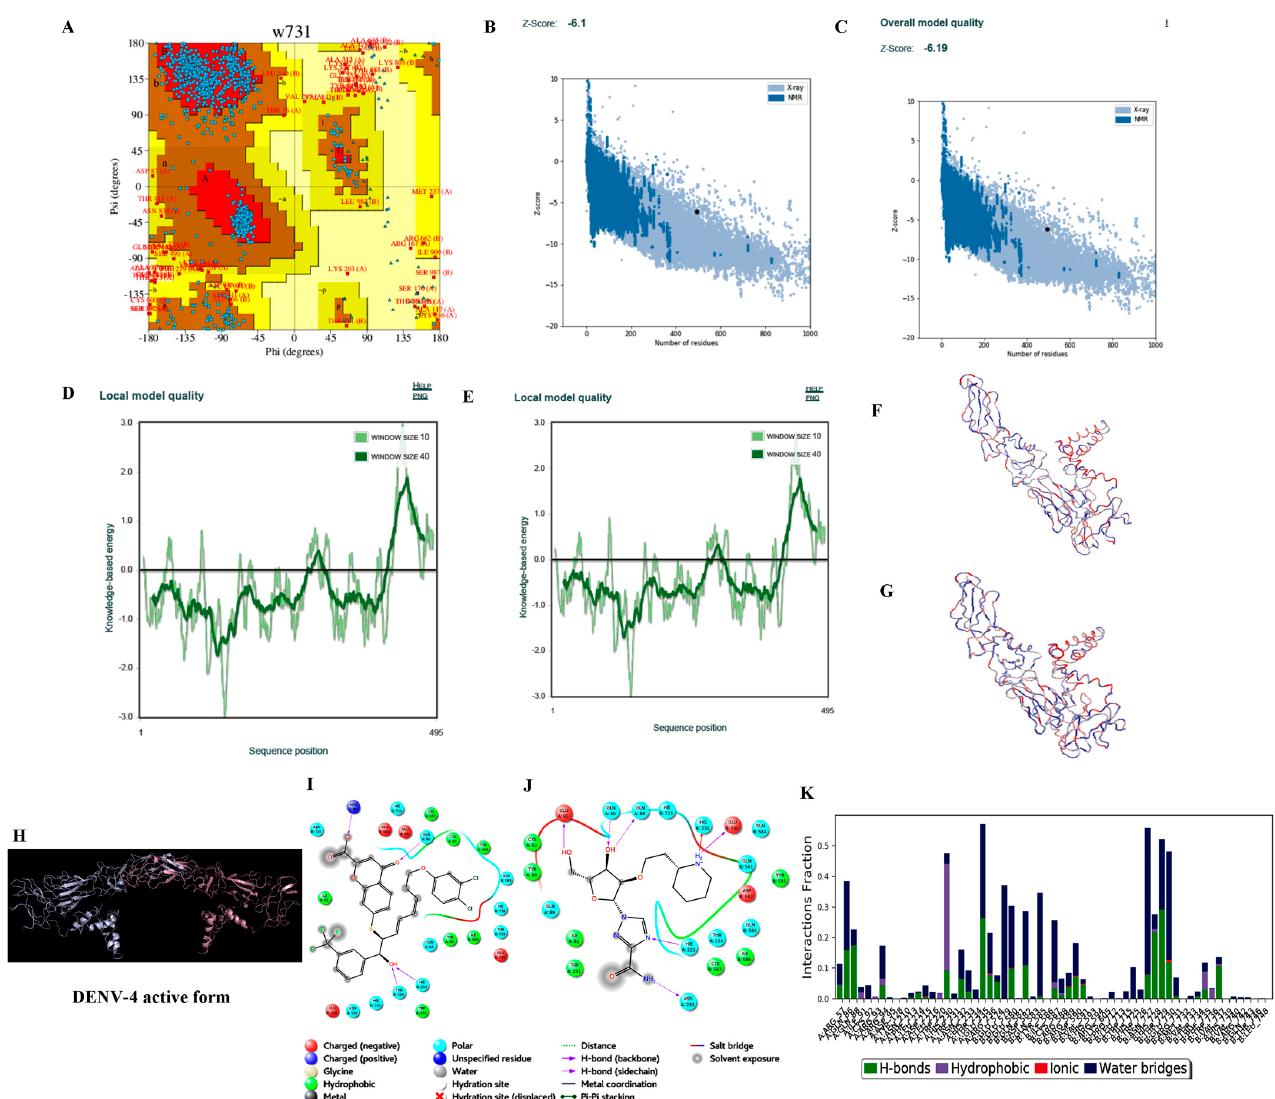
Figure 5. Structure validation of DENV-4 by various in silico methods. ( A ) PROCHECK analysis (Ramachandran plot of the best DENV-4 model) ( B ) Model quality before minimization (ProSA) ( C ) Model quality after minimization (ProSA) ( D ) Per residue model quality before minimization. ( E ) Per residue model quality after minimization ( F ) Ribbon form of DENV-4 structure before minimization (blue color—least energy regions; red color—highest energy regions). ( G ) Ribbon form of DENV-4 structure after minimization (blue color—least energy regions; red color—highest energy regions). Structure of DENV-4 envelop protein and docking and dynamics interactions of reference and novel inhibitor molecules. ( H ) Cartoon representation of the best DENV-4 dimer model (A chain in silver color and B chain in brown color). ( I ) Best docked published inhibitor (NITD448) interactions with DENV-4. ( J ) Best docked lead 1 (RGBLD-4) interactions with DENV-4; In DENV-4, RGBLD4 showed interactions with 21 amino acids. Seven hydrogen bonding were found with Glu85, Gln86, Gln88, His230, His233, Asn232 of chain A; Glu85 of chain B. Non-bonding interactions include polar, hydrophobic and negative charge with amino acids Thr234, Trp231, Ile91, Gln89, Tyr90, Cys92 of chain A; His230, Gln89, Gln86, Tyr90, Asp87, Gln88, Ile91, Cys92 of chain B. ( K ) DENV-4-RGBLD-4 (protein ligand contacts) in 100 ns molecular dynamics